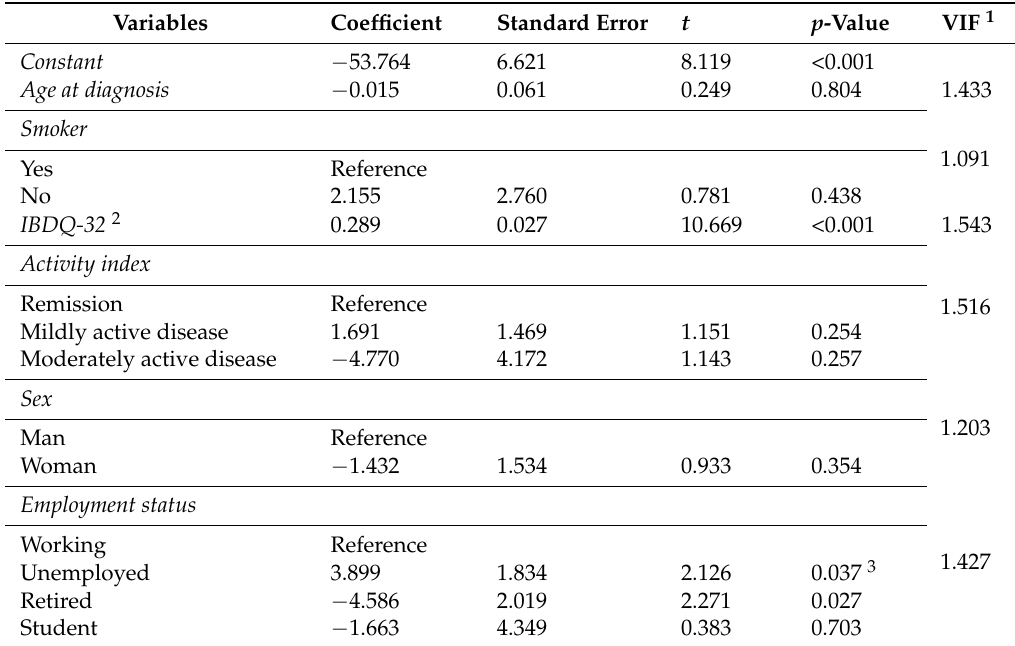
Table 5. Inflammatory Bowel Disease Disability Index linear regression model for ulcerative